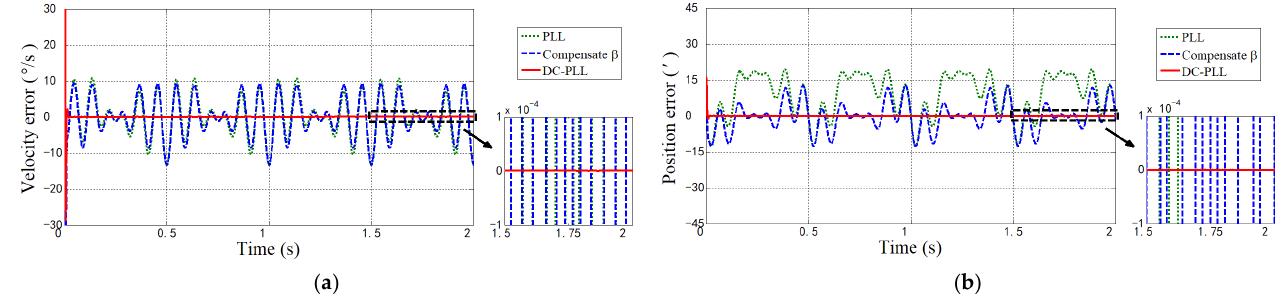
Figure 7. Spectrum of phase detector error at fixed speed.